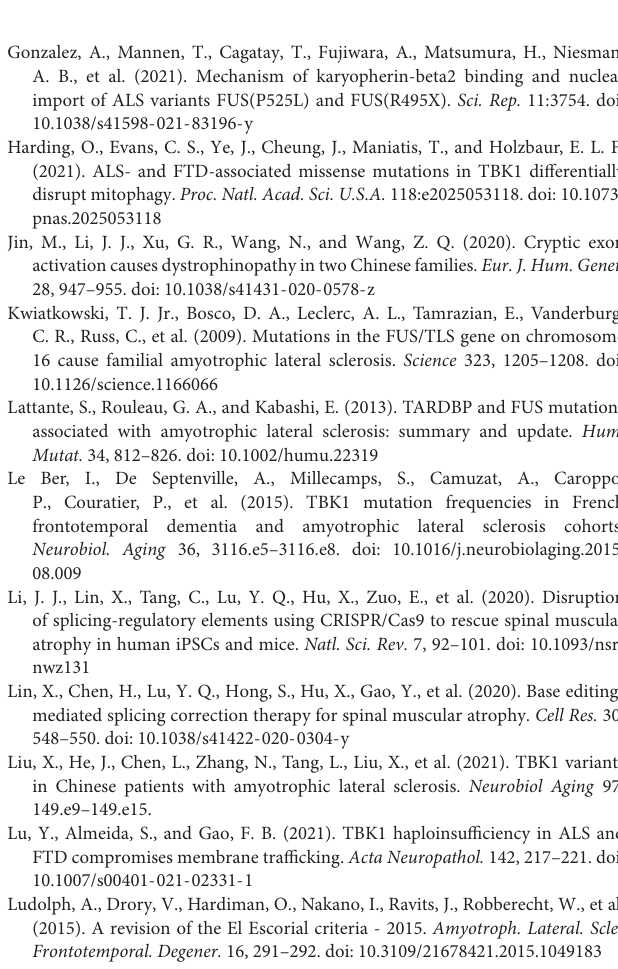
Supplementary Figure 1 | Splicing modes of TBK1 with intronic variants in HEK293T and HeLa cells. (A) T-A clone results of normal splicing mode (WT) and three aberrant splicing modes (deletion of 8bp, insertion of 2bp, and insertion of 10bp) of TBK1 with c.1522-3T > G in HEK293T and HeLa cells, respectively. Fractions below roman numerals I, II, and III showed the proportion of the four splicing modes (WT and aberrant) respectively, from three independent repetitions. (B) Schematic of normal splicing mode (WT) and aberrant splicing mode (MUT) of TBK1 with c.2066 + 4A > G in HEK293T and HeLa cells, respectively. Green lines show normal splicing modes, red lines show aberrant splicing modes, yellow boxes indicate exons, gray boxes indicate introns. E17: exon 17, E18: exon 18, E19: exon 19, E20: exon 20. Fractions below roman numerals I, II, and III showed the proportion of the two splicing modes (WT and MUT) respectively, from three independent